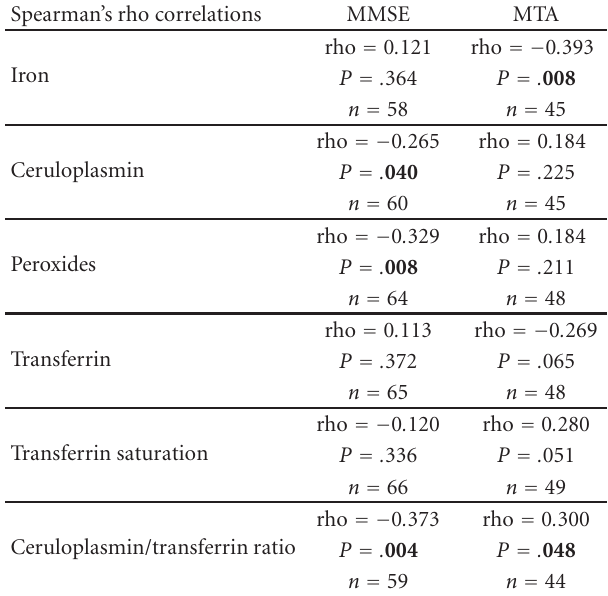
Table 3: Correlations between outcomes of MMSE, MTA evalua- tion, and biological variables under